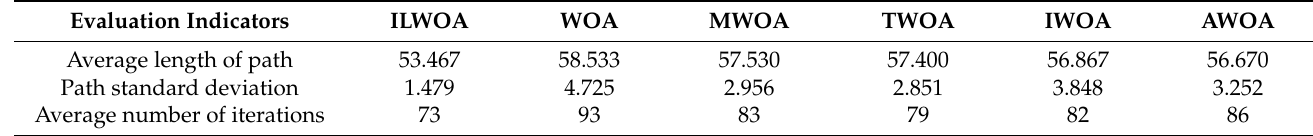
Table 5. Experimental results of Environment 2 scenarios.